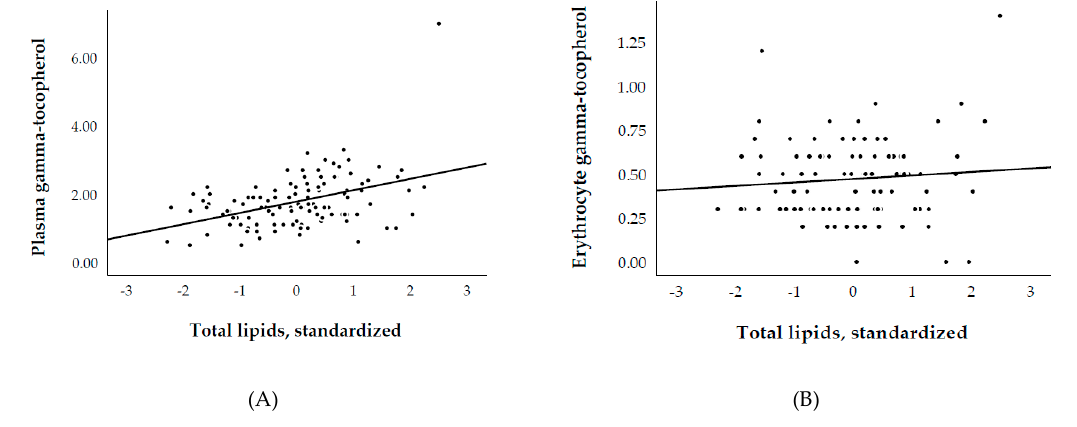
Figure 2. Association of (A) plasma (R 2 = 0.18) and (B) erythrocyte (R 2 = 0.01) γ -tocopherol with total lipids. Plasma and erythrocyte γ -tocopherol are expressed in mg/dL and mg/10 13 erythrocytes, respectively.